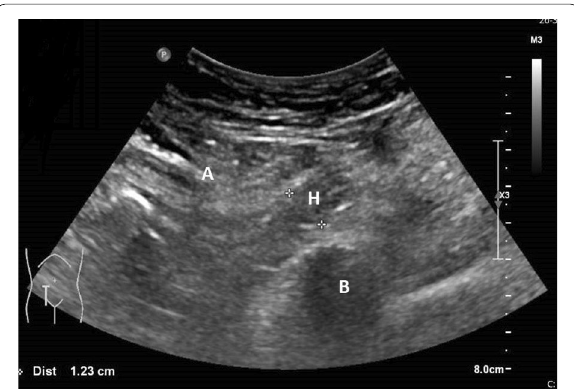
Fig. 2 Illustration of a false positive case. Philips Epiq 7G with a convex transducer 5–1 MHz. H presumed hernia, B bone (hip), A abdominal